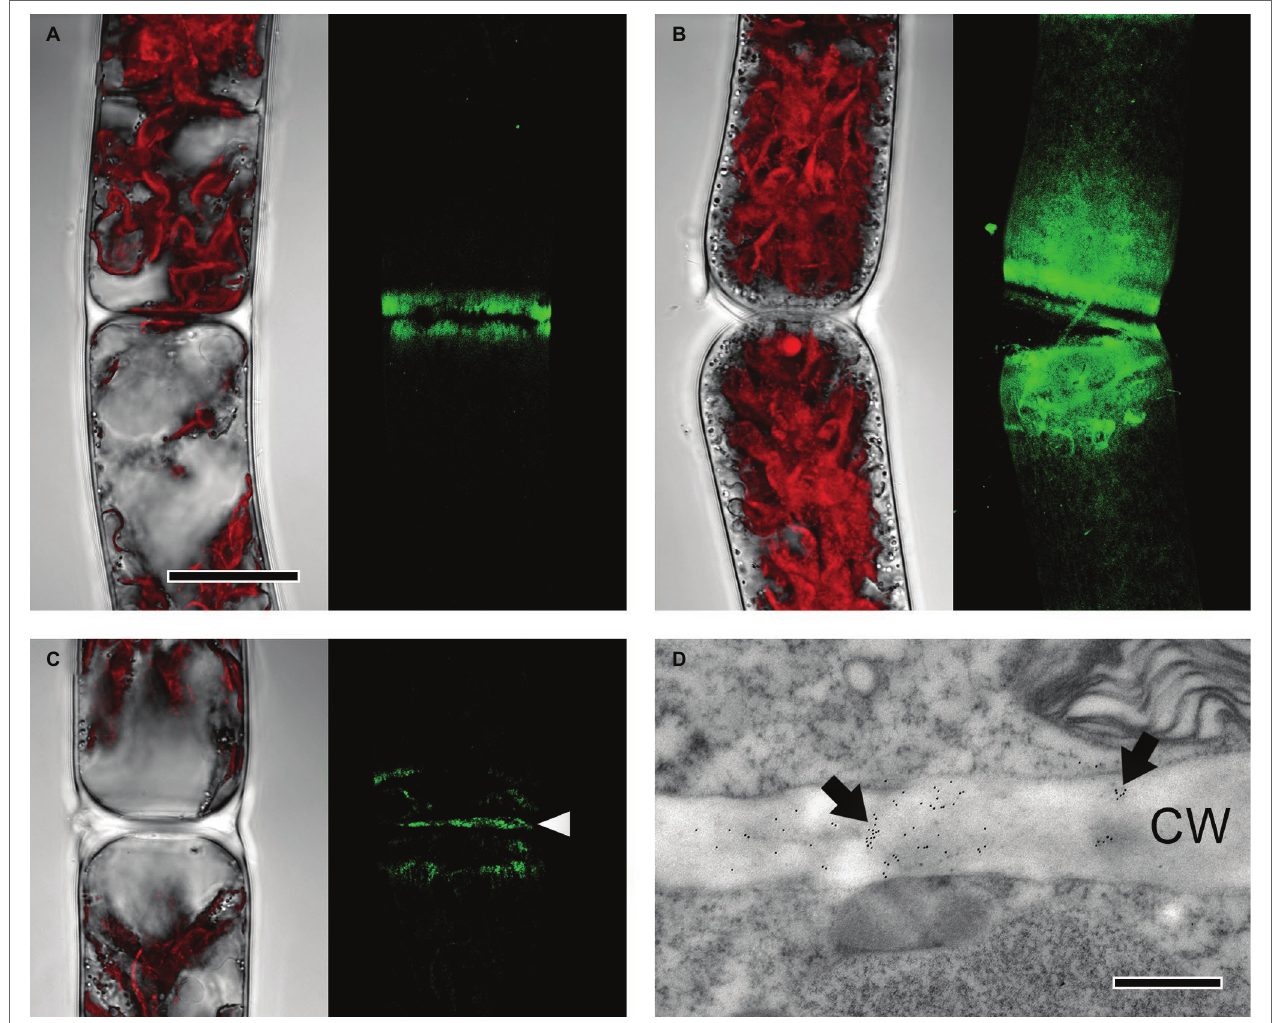
FIGURE 4 | Detection of partially methylesterified homogalacturonan by JIM7 in Zygnema filaments. JIM7 labeling was visualized in young (A,C,D) and old (B) filaments by confocal laser scanning microscopy ( A–C ; green, z-stacks) and TEM (D) . Corresponding bright-field images in (A–C) include red chloroplast autofluorescence. (A,B) Labeling strongest in areas close to cross cell walls, (C) signal in cross cell wall (arrowhead), (D) immunogold-labeling in cross cell wall (arrows; CW). Scale bars = 20 μm (A–C) , 500 nm (D)